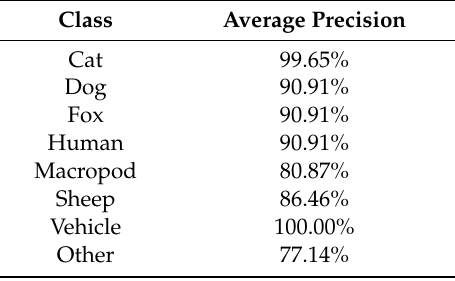
Table 2. Detection Summary results: New England NSW model (daylight). Randomly